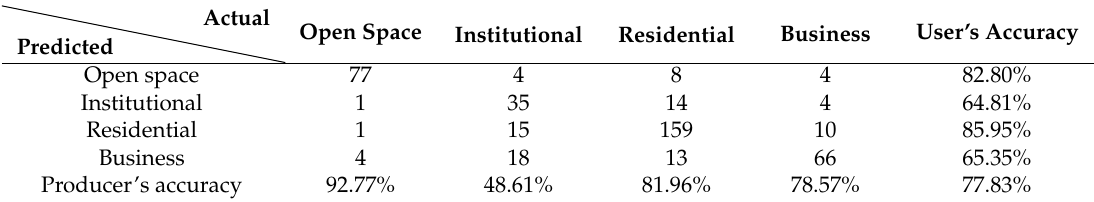
Table 3. Confusion matrix for the testing